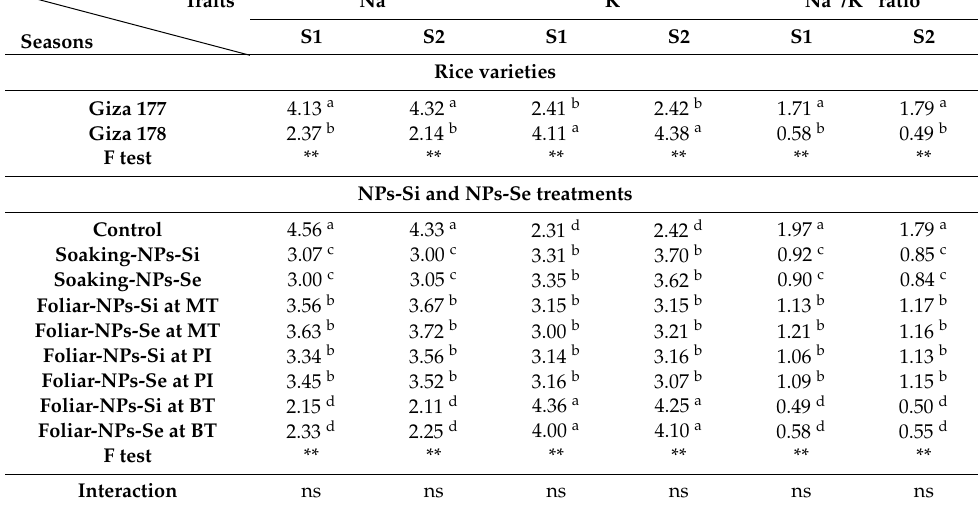
F test ** Interaction ns ns ns ns ns